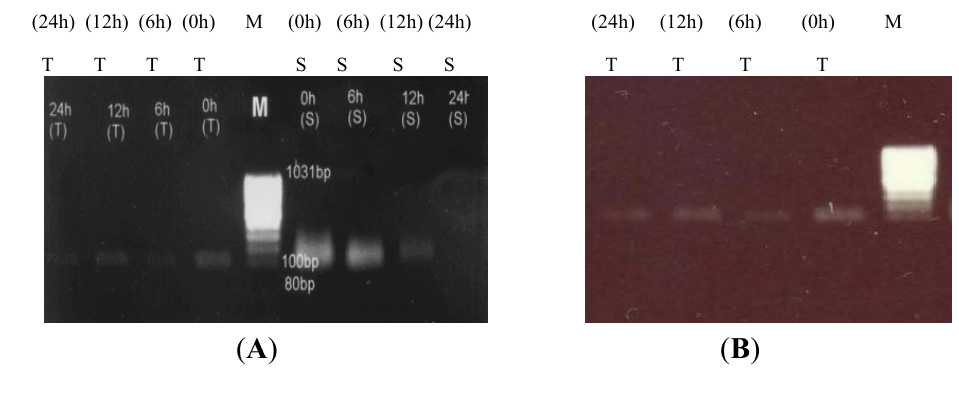
Figure 3. Proline dehydrogenase ( PDH ) gene expression in root and shoot tissues of salt-tolerant and salt-sensitive canola lines. ( A ) Proline dehydrogenase ( PDH ) gene expression in root tissues of two contrasting canola lines at different time intervals after the salinity treatment. ( B ) Proline dehydrogenase ( PDH ) gene expression in shoot tissue of two contrasting canola lines at different time intervals after